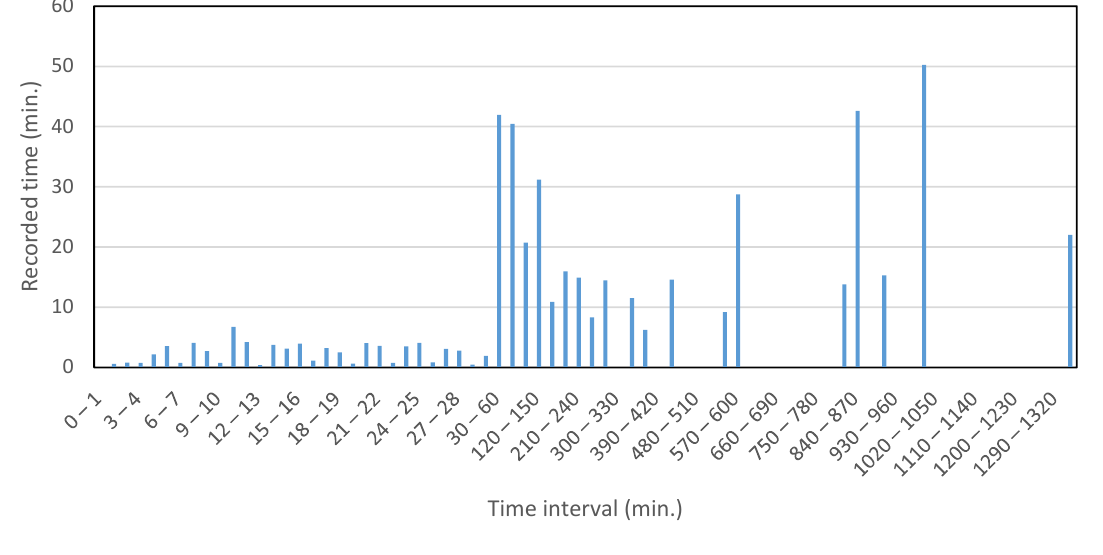
Figure 10. Distribution of trips according to travel time.